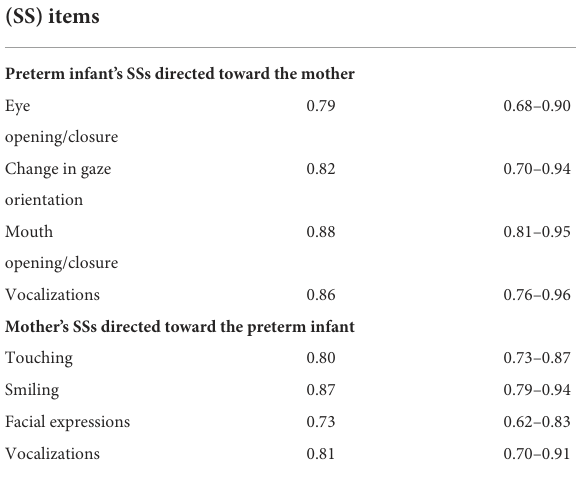
TABLE 2 Inter-rater